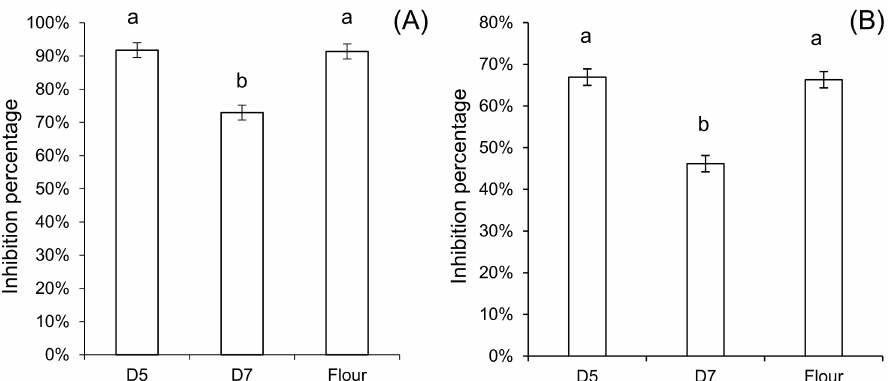
Figure 3. Inhibitory activity of the albumin / globulin extract after heat treatment against α -amylase from ( A ) yellow mealworm Tenebrio molitor , and ( B ) from porcine pancreas. D5, yeast-fermented dough; D7, wheat sourdough. Each letter indicates groups with statistical di ff erence ( p < 0.05, a vs. b) using triplicates and one-way analysis of variance (ANOVA) with Tukey’s honest significance test